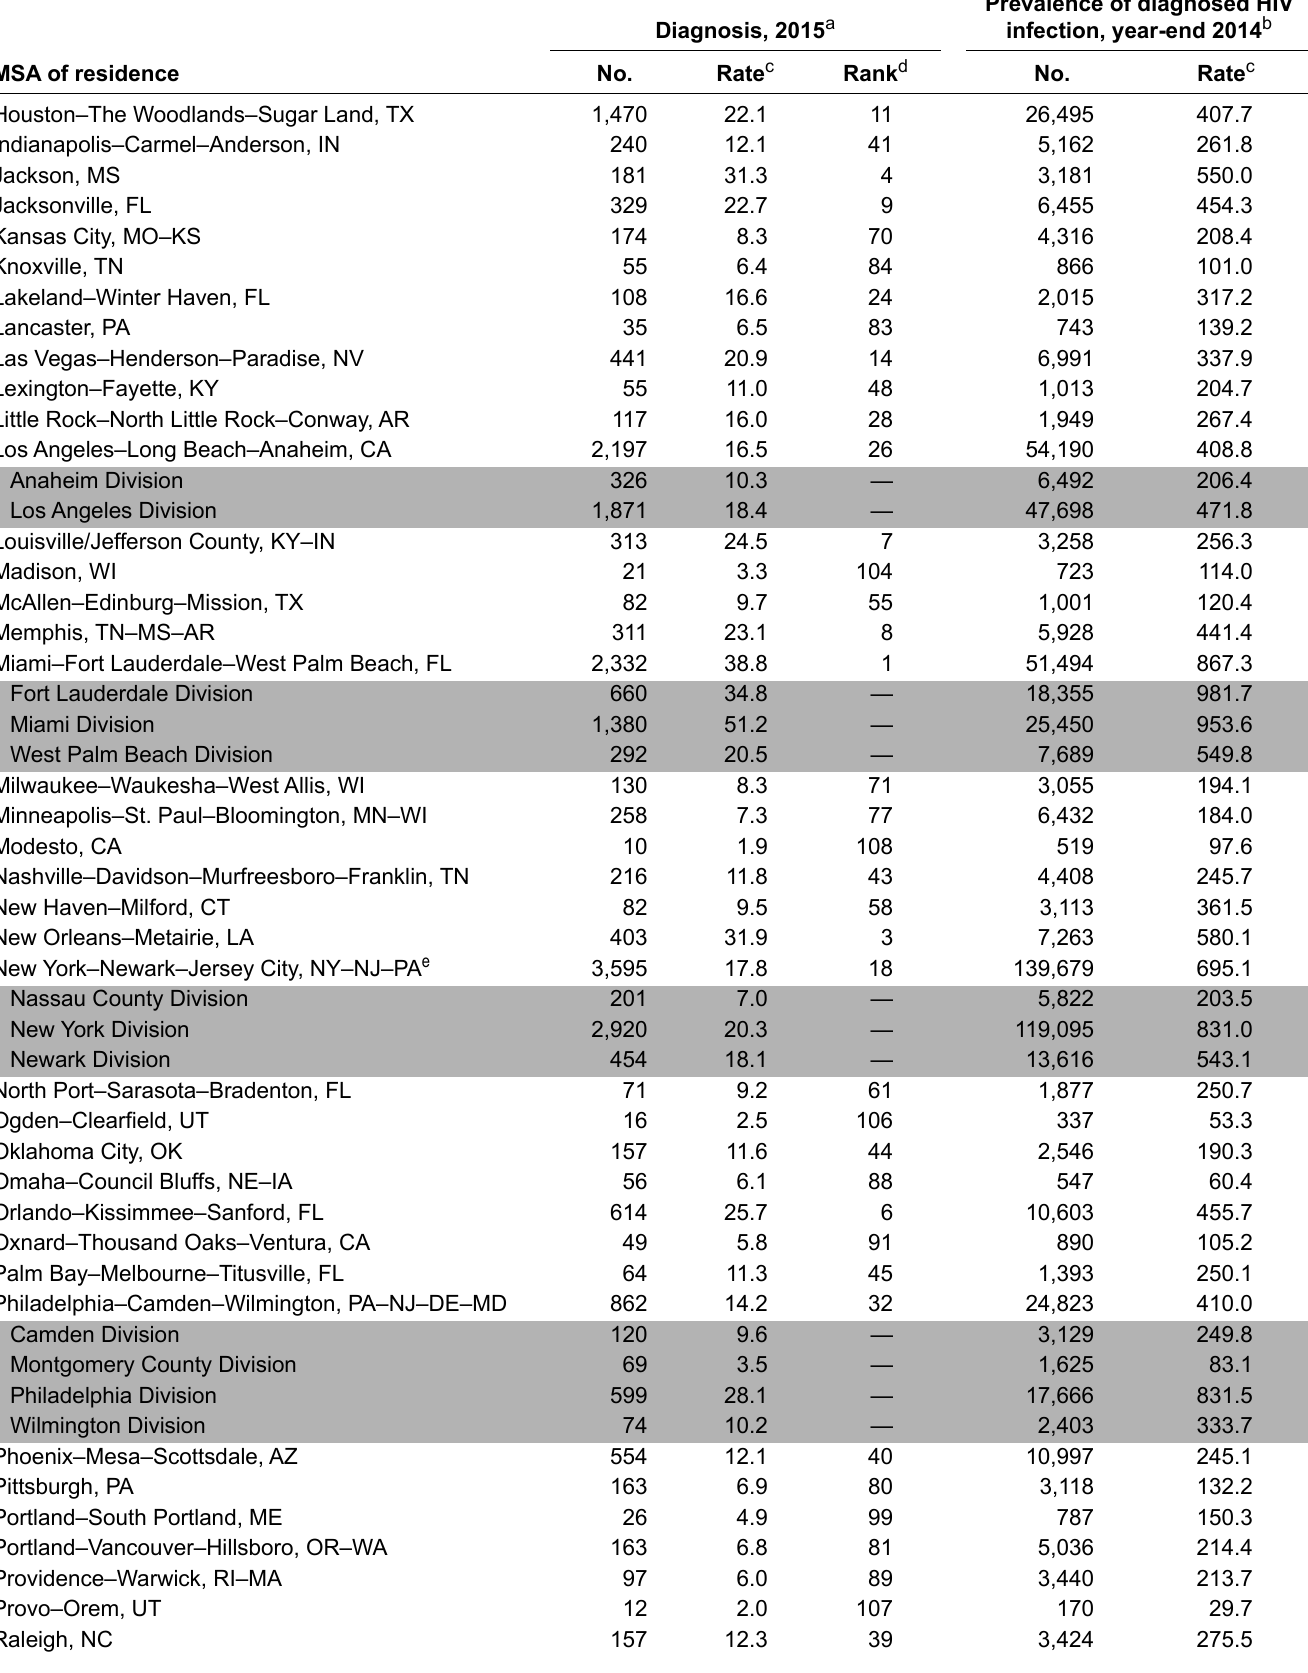
Table 26. Diagnoses of HIV infection, 2015, and persons living with diagnosed HIV infection (prevalence), year- end 2014, by metropolitan statistical area of residence—United States and Puerto Rico